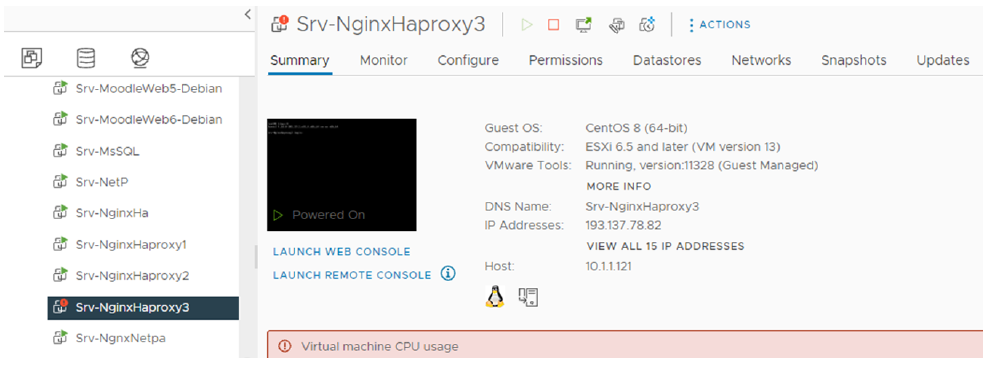
Figure 6. ESXI CPU usage warning.